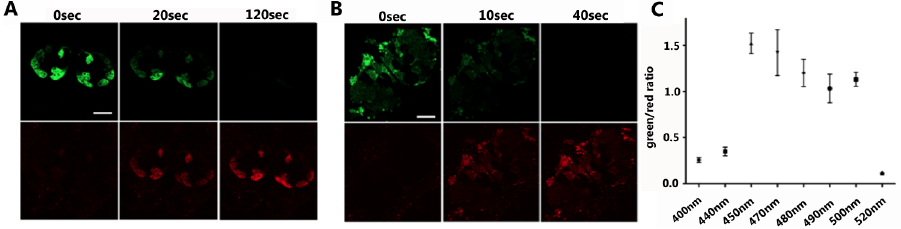
fluorescence intensity (y-axis) following exposure to light from a Xenon lamp (x-axis).